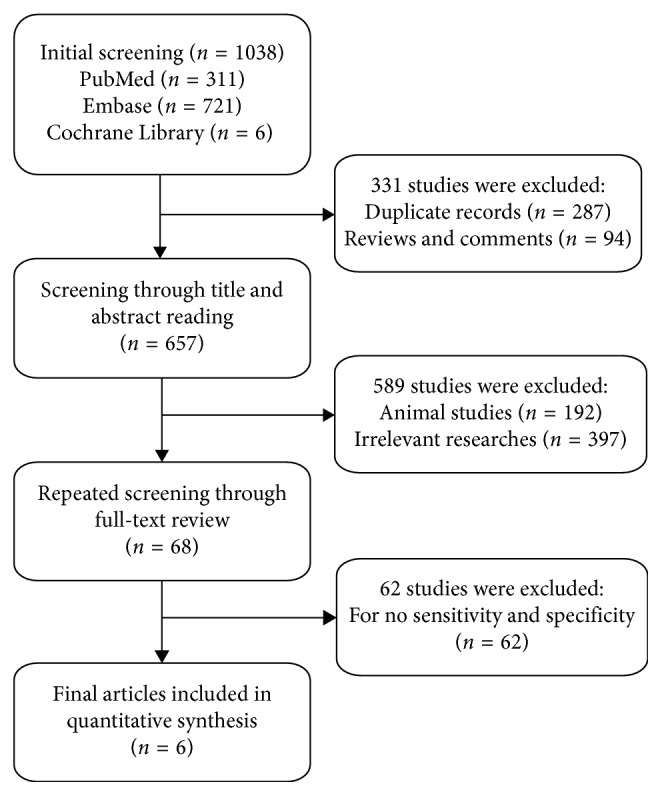
Flow chart of this systematic review and meta-analysis to identify inclusion studies.